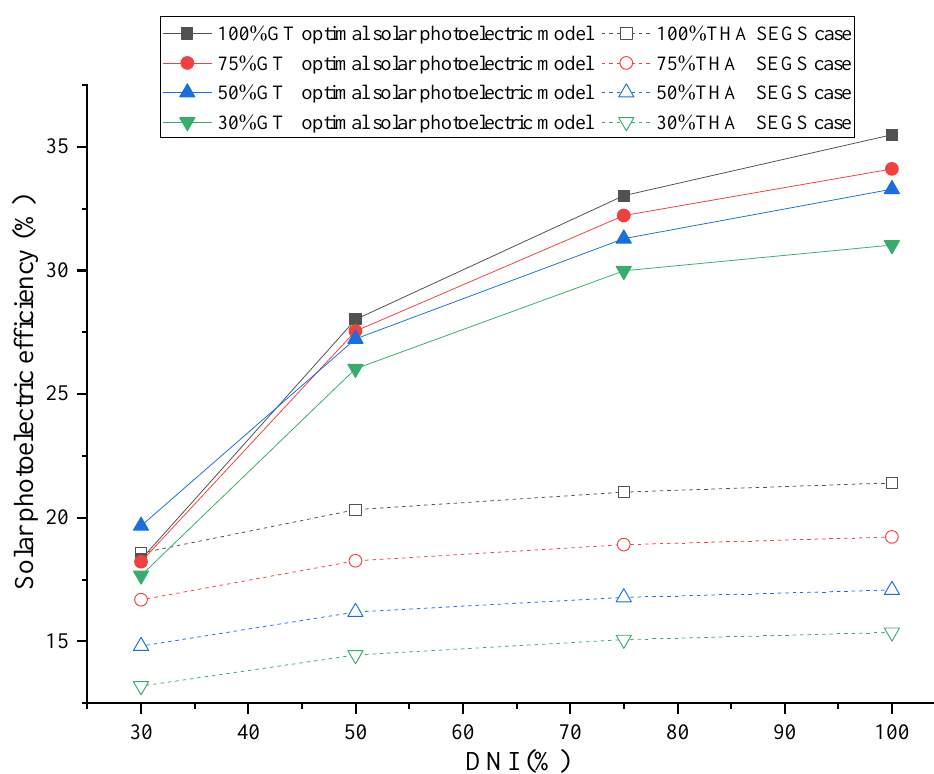
Figure 12. Solar photoelectric efficiency of ISCC for the optimization model and comparison group.